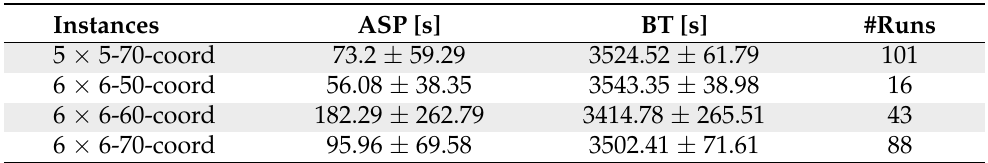
Table 3. Runtime distribution and number of timeout runs within the coordinated approach with timeout reached in the background theory (BT).